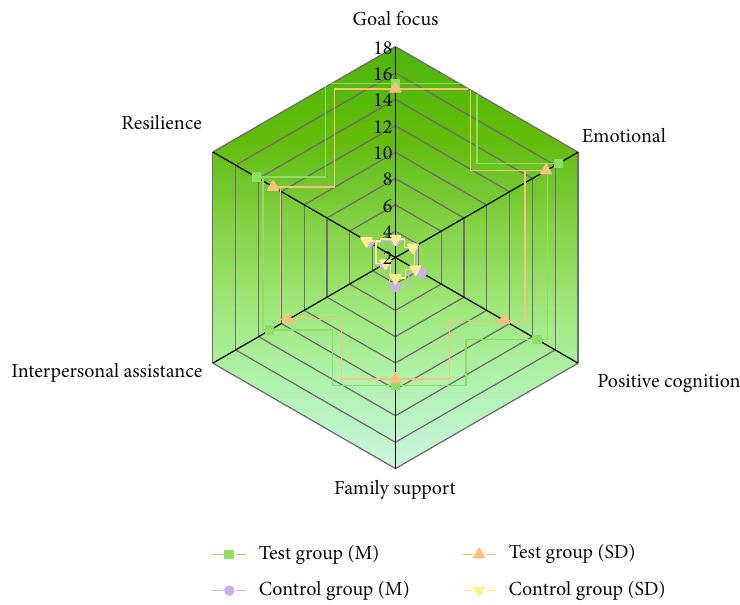
Figure 2: Analysis of variance before and after the experimental group and the control